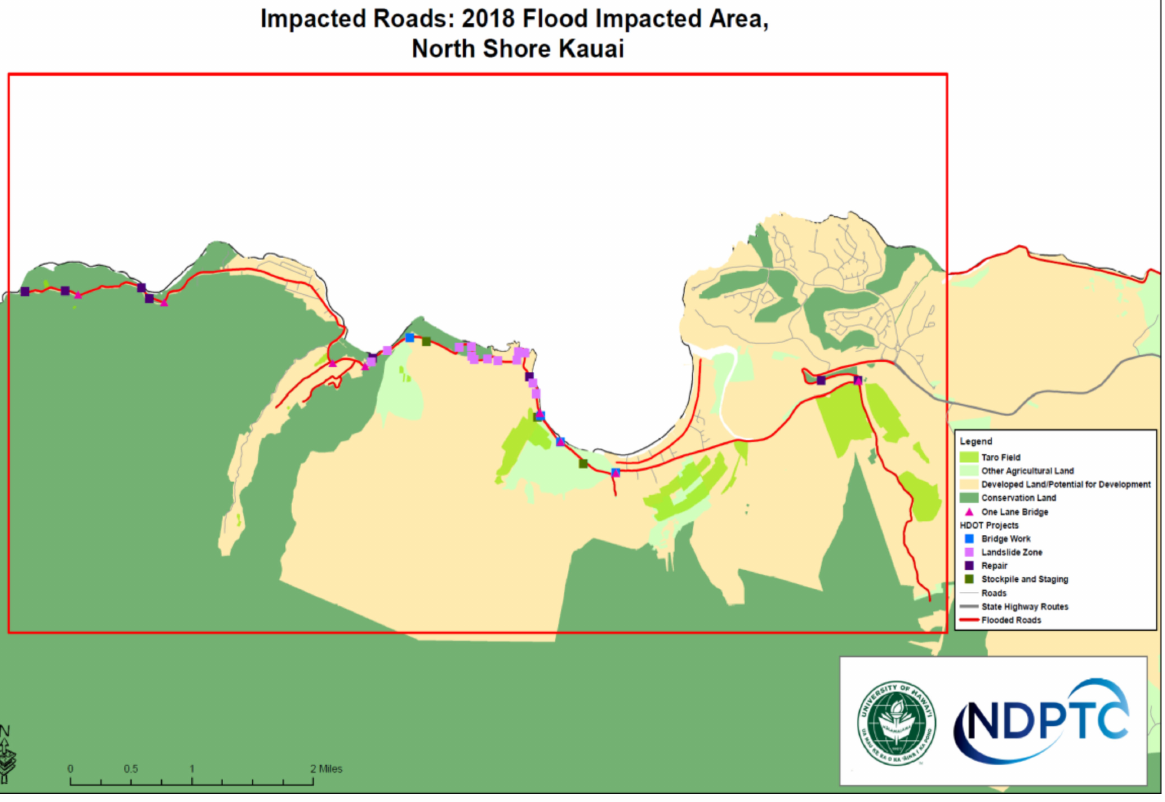
Figure 3. Flood damage locations, North Shore, Kaua’i, 2018